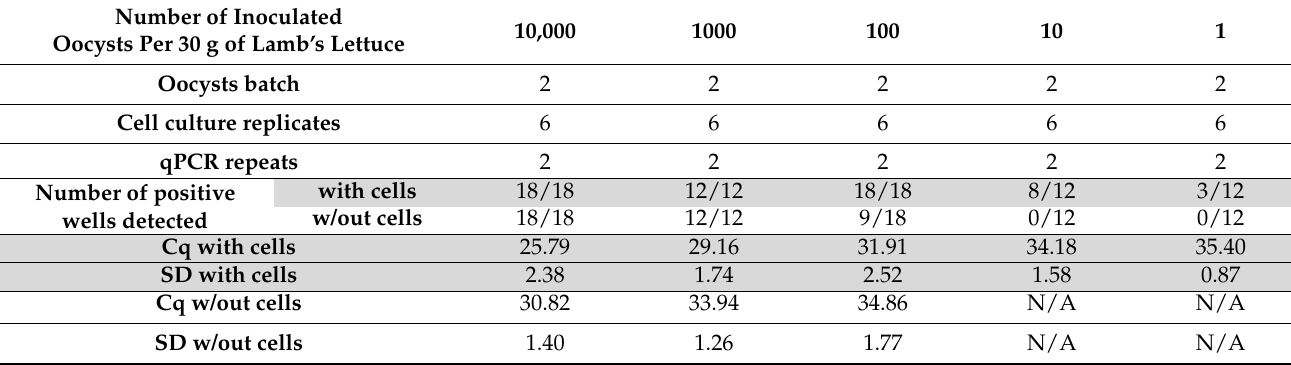
with Number of positive Table 2. CC–qPCR assay results for C. parvum oocysts recovered from lamb’s lettuce. wells detected